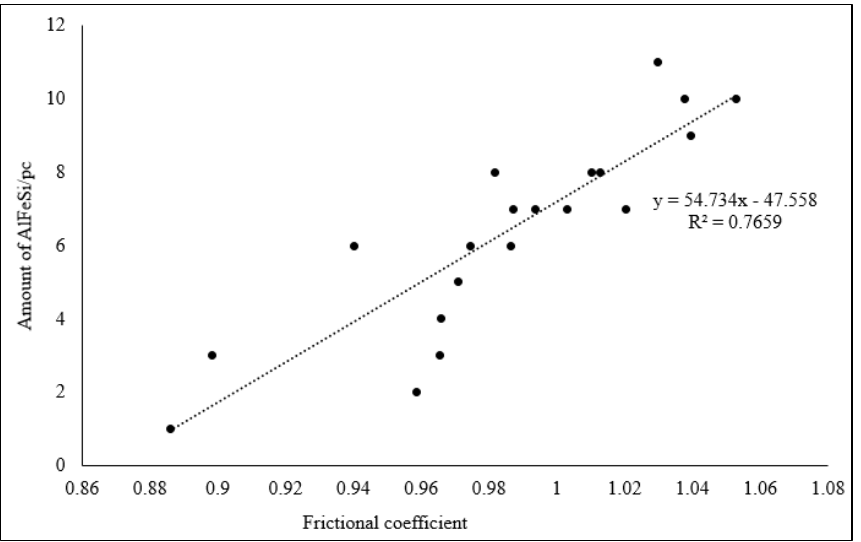
Figure 15. Relationship between the AlFeSi particles and the friction coefficient of Al6061.